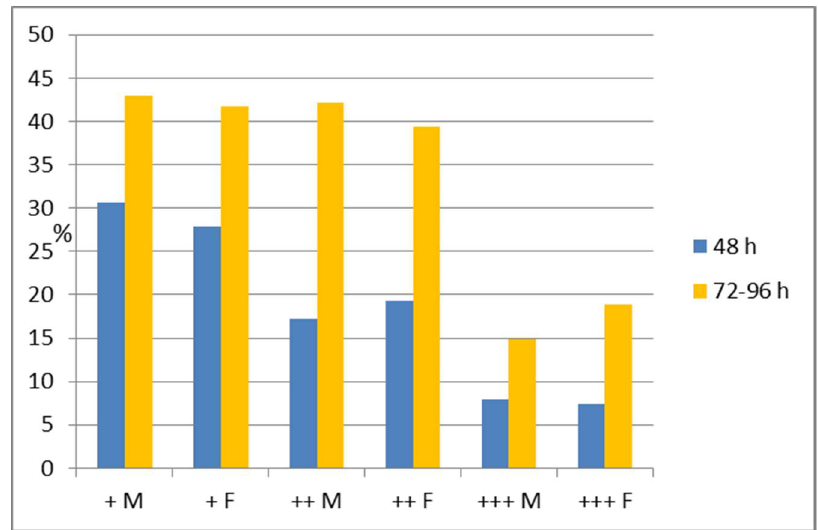
Figure 3. Patch test strength of reactions (%) to fragrance mix-1 in men (M) and women (F) at 48 and 72 – 96 hours.